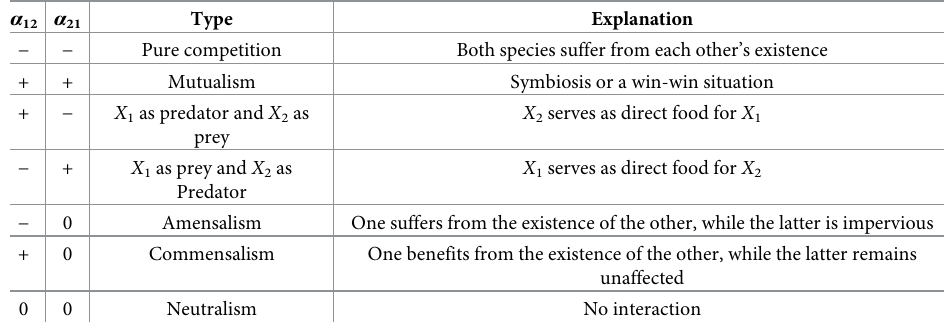
Table 1. Ecological relation types according to the sign of α 12 and α 21